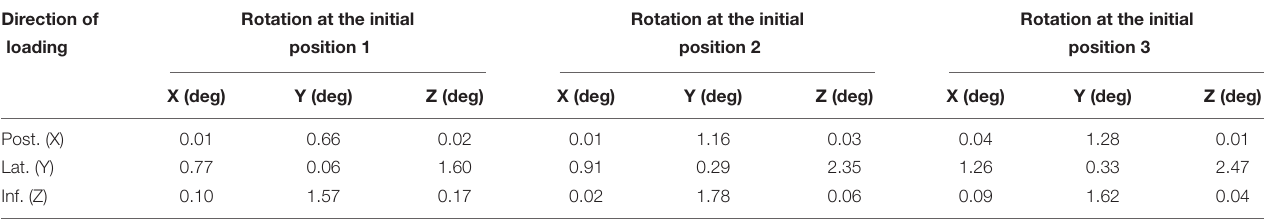
TABLE 1 | Rotation (absolute value) of the linear actuator according to the directions of the loading (magnitude of 290 N) and the initial positions of the linear actuator. Direction of Rotation at the initial Rotation at the initial Rotation at the initial loading position 1 position 2 position 3 X (deg) Y (deg) Z (deg) X (deg) Y (deg) Z (deg) X (deg) Y (deg) Z (deg) Post. (X) 0.01 0.66 0.02 0.01 Lat. (Y) 0.77 Inf. (Z)